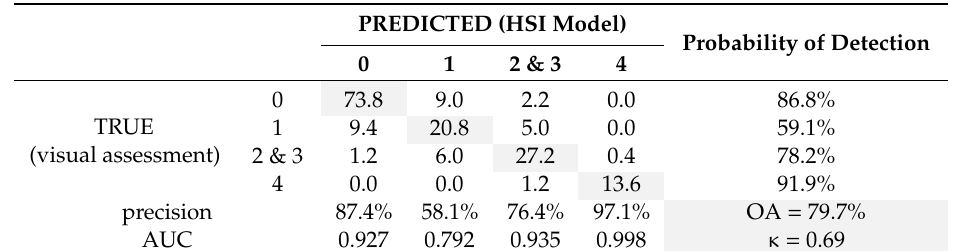
Table 2. Confusion matrix with class 2 and 3 merged for vigor groupings classification between TRUE classes (from visual assessments) and PREDICTED classes (from hyperspectral imaging model) averaged over 5 dates. 0 = non-inoculated control seedlings, 1 = infected and vigorous, 2 = infected and moderately vigorous, 3 = infected and sickly, 4 = infected and dead. Probability of detection is the number of correct labels divided by the total number of observed seedlings in that class; precision is the number of correct labels divided by the total predicted seedlings in that class; AUC is the average area under the curve for a receiver operating characteristic curve for that class versus the rest; OA is the overall accuracy, and; κ is the kappa coe ffi cient. Note that OA improved by 5.5 percentage points compared to the results in Table